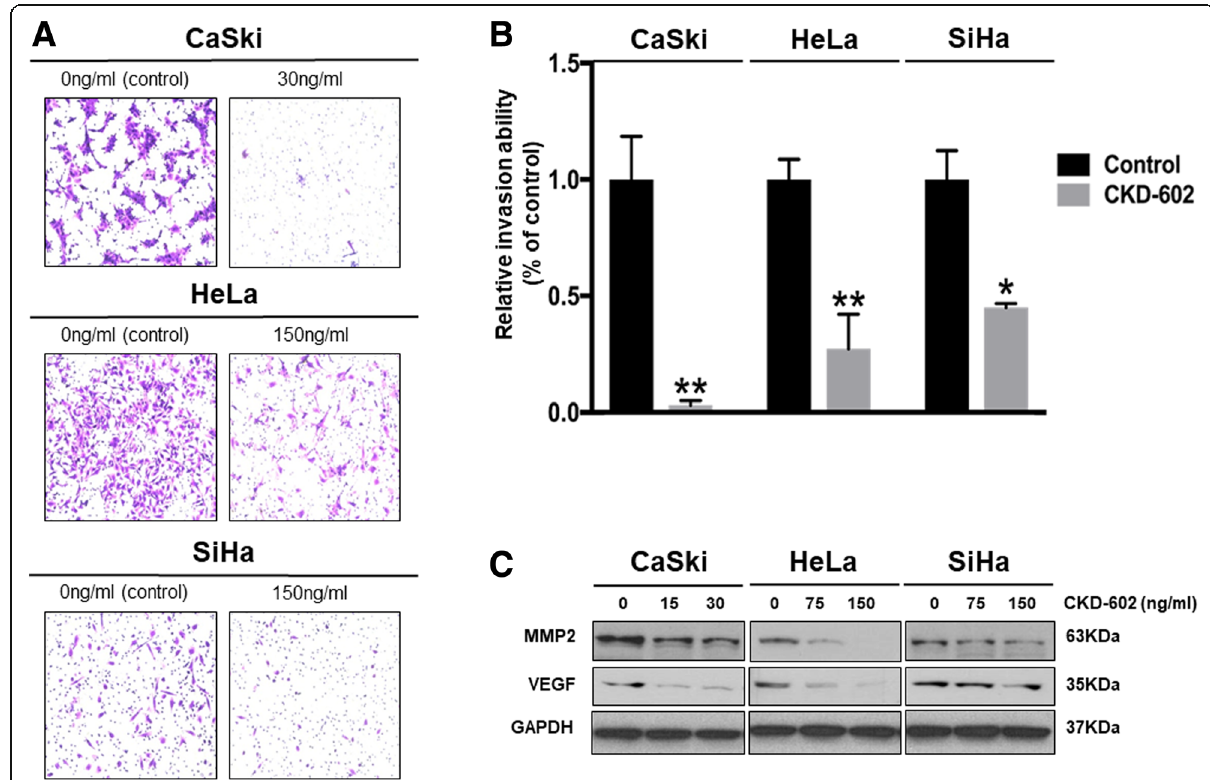
Fig. 3 Invasive ability of CKD-602 in cervical cancer cells. a. Photomicrographs showing invasive potential of CKD602 in cervical cancer cells using matrigel precoated transwell assay (× 200) and b. Mean ± SEM (* p < 0.05 and ** p < 0.01). c. Western blot analysis of cell invasion-related proteins in cervical cancer